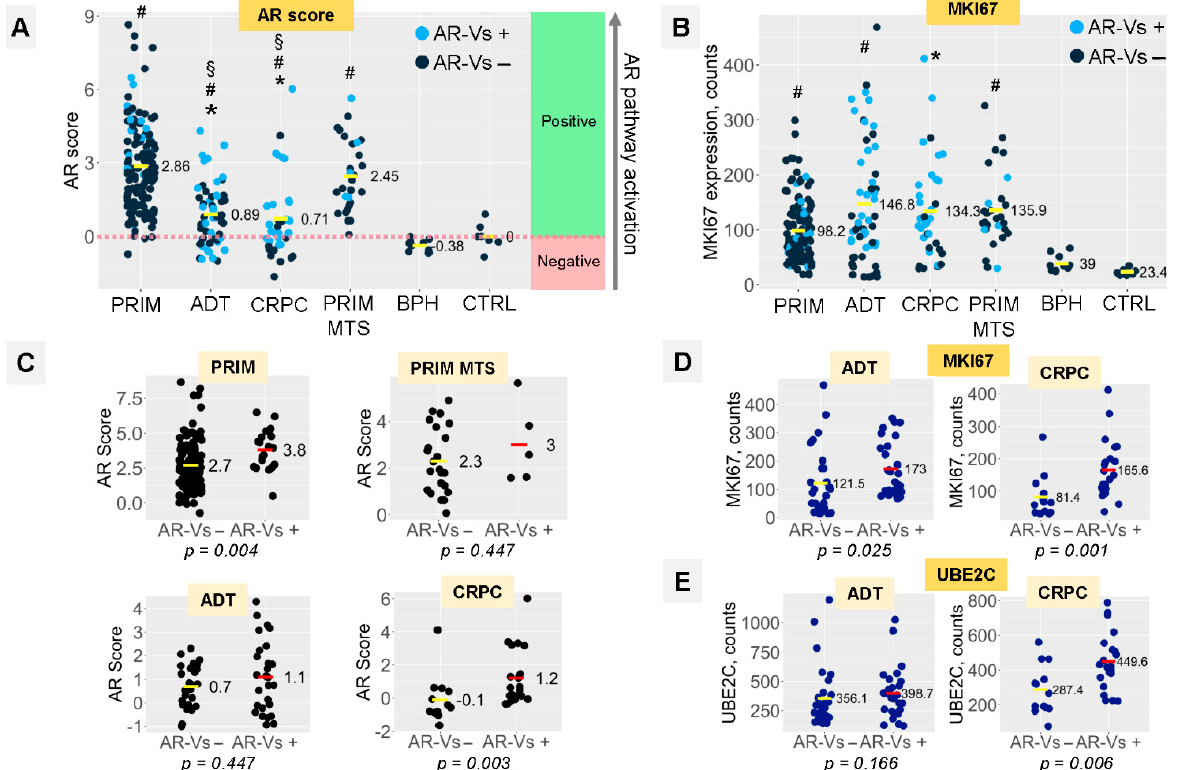
Figure 4. ( A ) Distribution of AR scores in study groups (cumulative score of AR pathway activation, calculated based on mRNA expression of 10 transcriptional targets of AR). Light blue points express any of the AR-V splice variants (V1, V3, V7, V9); dark blue points do not express AR-V splice variants. “Positive” area represents AR score in “activated” range compared to reference group (CTRL: benign non-hyperplastic prostate tissue). “Negative” area represents depression in AR signaling. ( B ) mRNA expression of proliferation marker MKI67. ( C ) Analysis of AR score distribution in four “tumor” study groups in relation to dependence on AR-V splice variant expression. ( D ) Analysis of MKI67 mRNA expression in ADT and CRPC groups in relation to dependence on AR-V splice variant expression. ( E ) Analysis of UBE2C mRNA expression in ADT and CRPC groups in relation to dependence on AR-V splice variant expression. p -levels calculated using Mann–Whitney U-test. Statistical significance ( p < 0.05): * vs. PRIM group, # vs. CTRL group, § vs. PRIM MTS group.